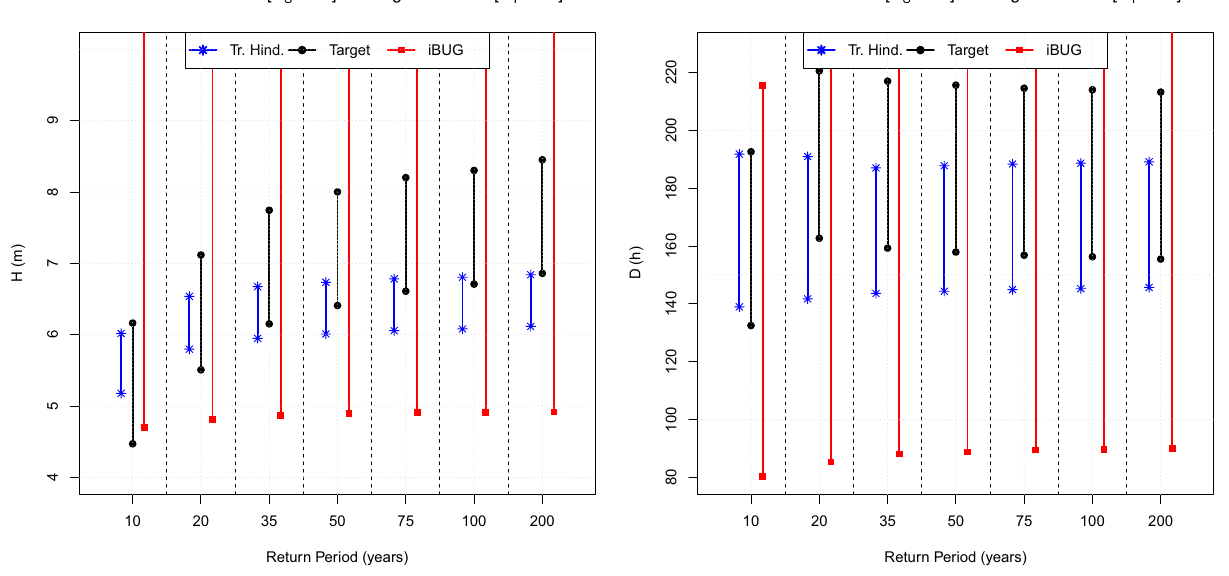
Figure 2. Comparison of Design values: the Gibraltar case. The plot shows the CI’s of the Target design values (black) associated with the RP’s indicated on the horizontal axis. The blue and red CI’s represent, respectively, the corresponding estimates computed via the Traditional Hindcasting and the iBUG techniques. The variables of interest ( H and D ) are indicated in the title, as well as the labels of the buoys considered and the Source ( N S ) and Target ( N T ) sample